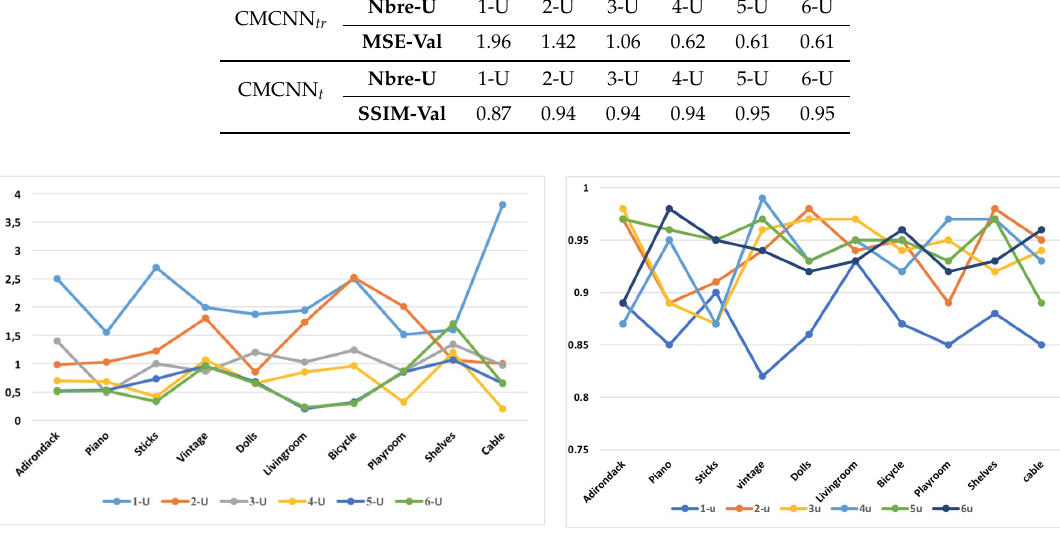
Figure 11. The values of MSE and SSIM in terms of number of used D-units for some tested images: (left) MSE; and (right) for SSIM.